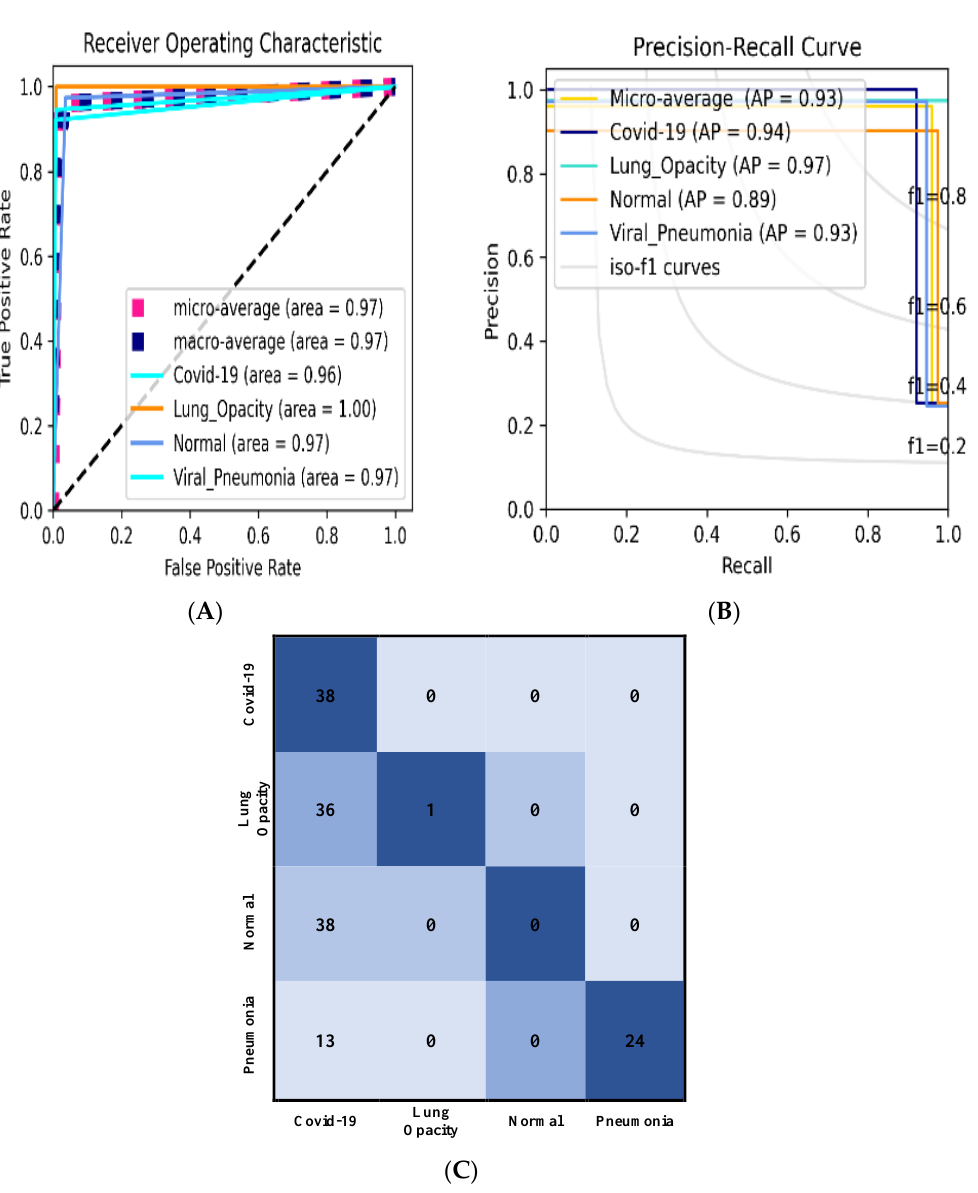
Figure 6. The optimized setting results include ( A ) ROC and ( B ) PR curve of the 10 −4 learning rate and categorical cross-entropy loss function, and ( C ) Hit rate diagram, based on Data_A. Table 8. Classification results of the backbone vs. proposed model based on ROC and PR curve using Data_A.